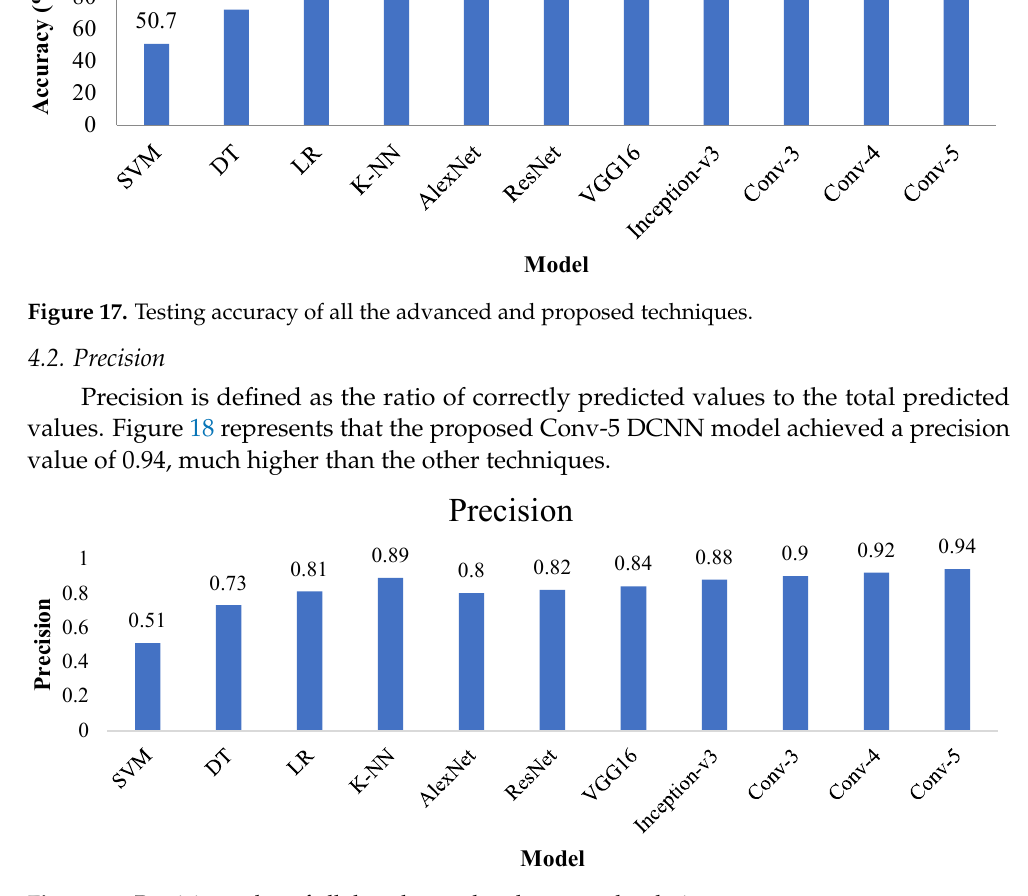
Figure 18. Precision value of all the advanced and proposed techniques.